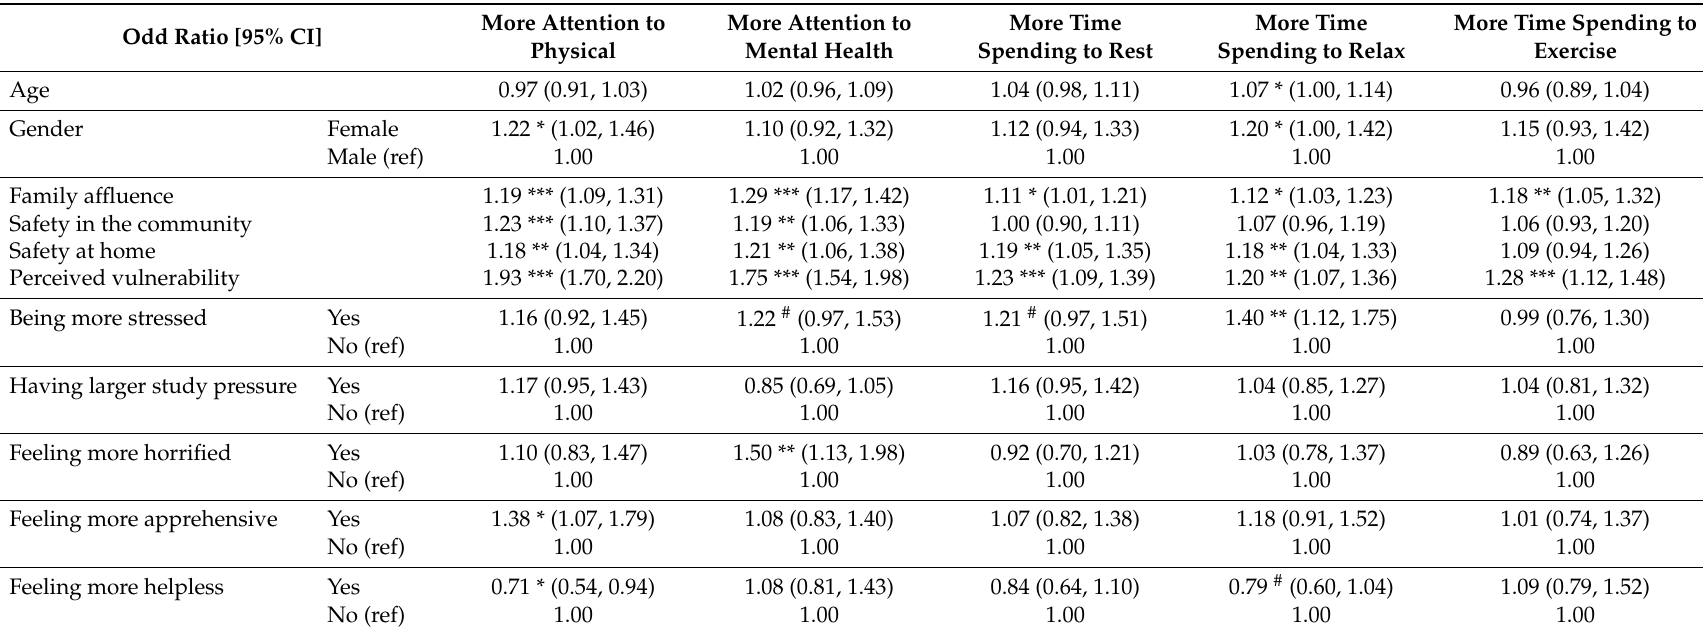
Table 6. Binary logistic regression on the impact on positive lifestyle